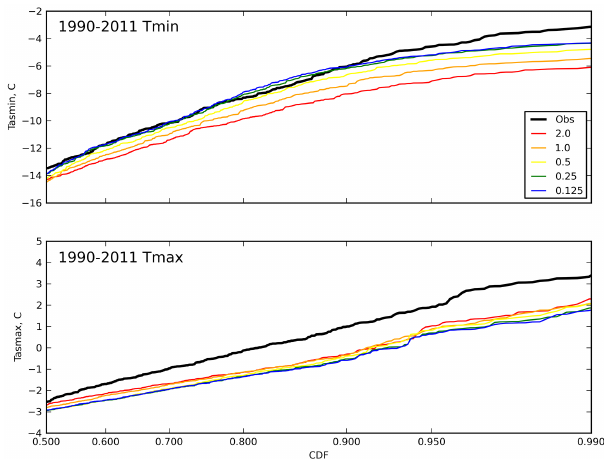
Figure 4. Cumulative distribution function plots (for quantiles 0.5– 0.99) of bias-corrected and spatially disaggregated daily precipita- tion for a single grid cell at latitude 45, longitude − 116. Spatial resolution in degrees at which the bias correction is performed is indicated in the legend. “Obs” is the CDF for the observations at 1 / 8 ◦ spatial resolution.